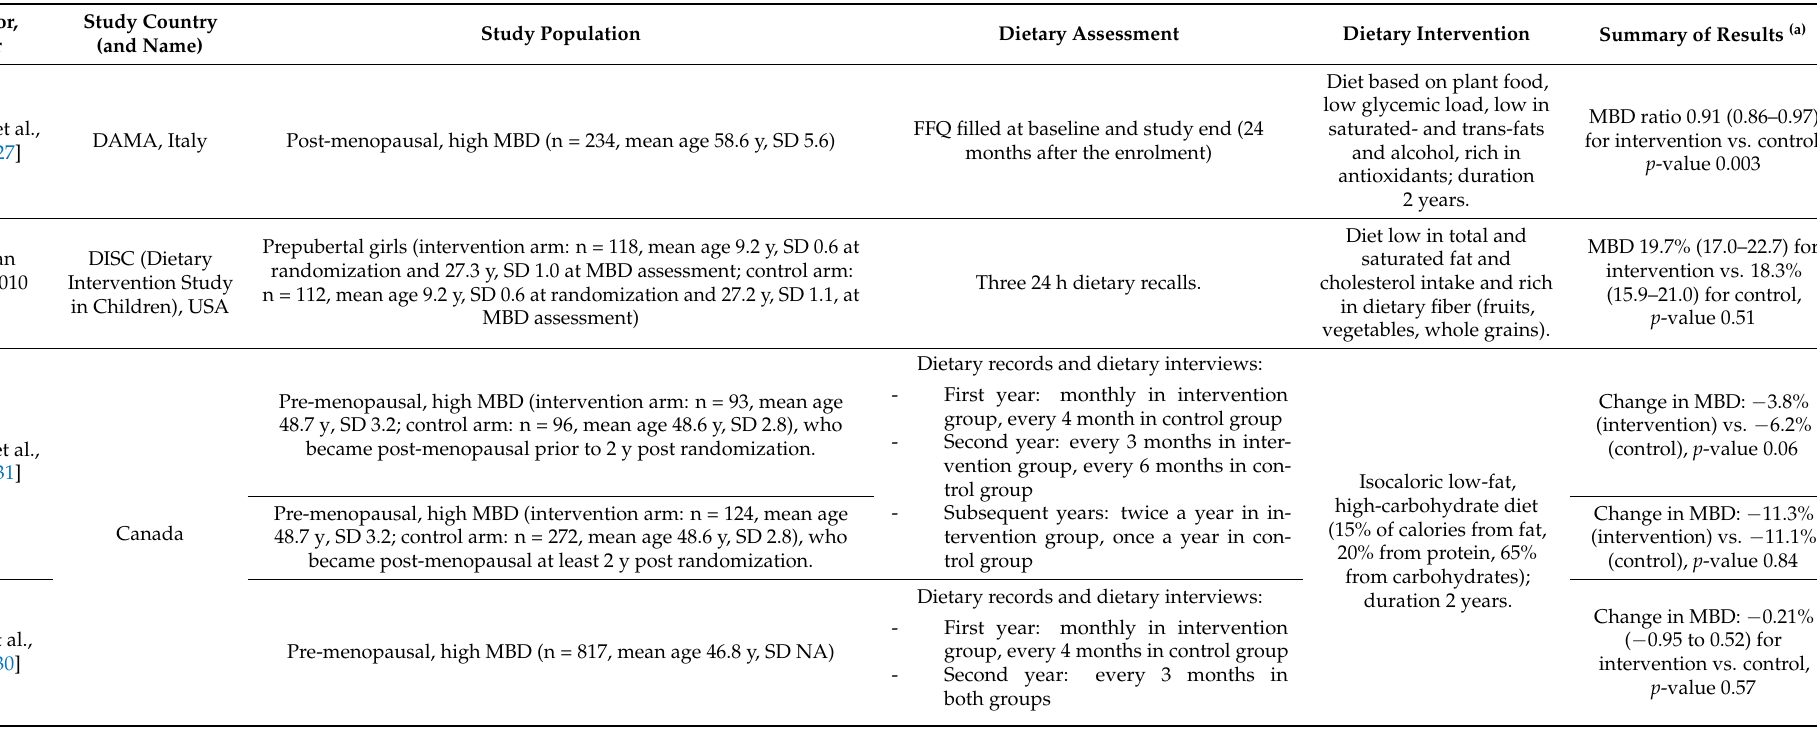
Table 3. Main characteristics and results (for the whole study group or stratified by menopausal status when available) of randomized controlled studies that investigated the effect of dietary intervention on mammographic breast